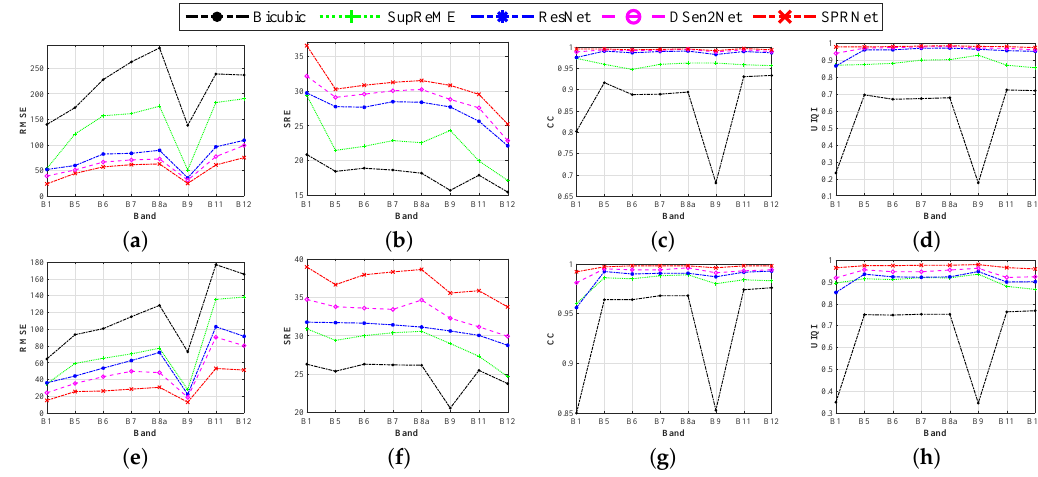
Figure 9. Pre-band error metrics for site 1 and site 2: ( a – d ) are RMSE, SRE, CC and UIQI of site 1. ( e – h ) are RMSE, SRE, CC and UIQI of site